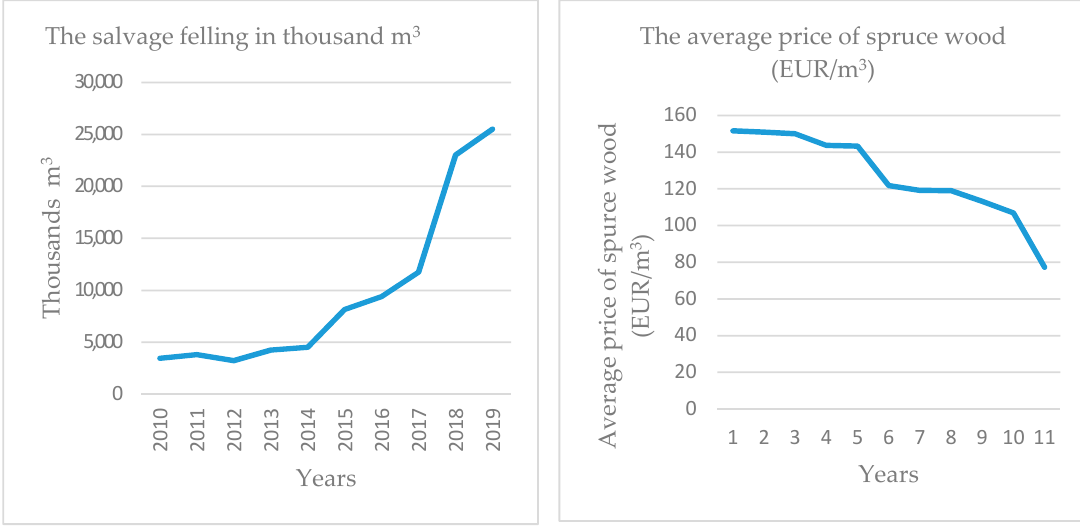
Table 1. Statistics for linear regression.